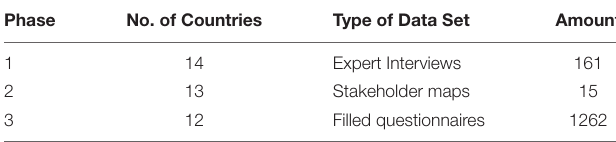
TABLE 1 | Data sets derived from three research